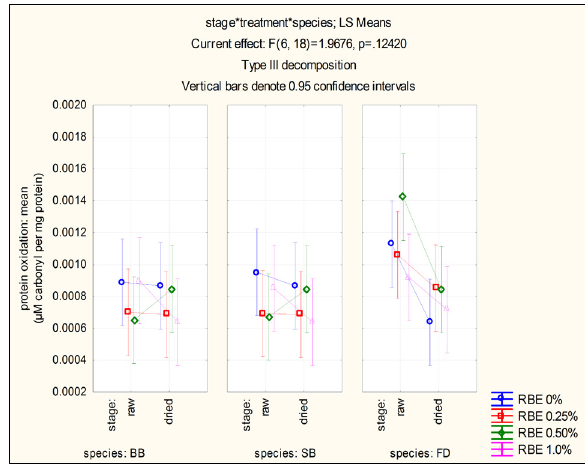
Figure 2: Protein oxidation results indicating the interaction between stage, treatment and species interaction (p>0.05) for droëwors prepared with different concentrations of rooibos extract